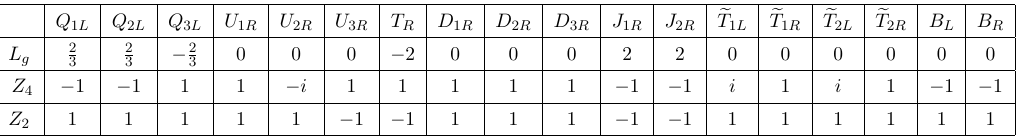
Table 1 . Quark assignments under Z 4 (cid:2) Z 2 and the values of generalized Lepton Number L g . L 1 L